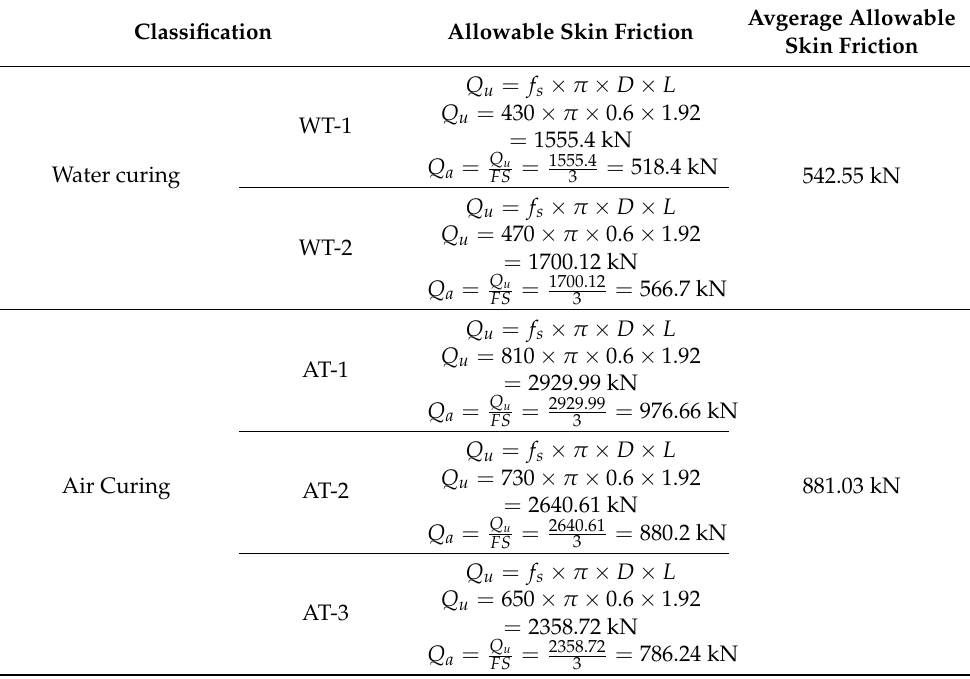
Table 6. Allowable skin friction according to the adhesion between the pile and grout.